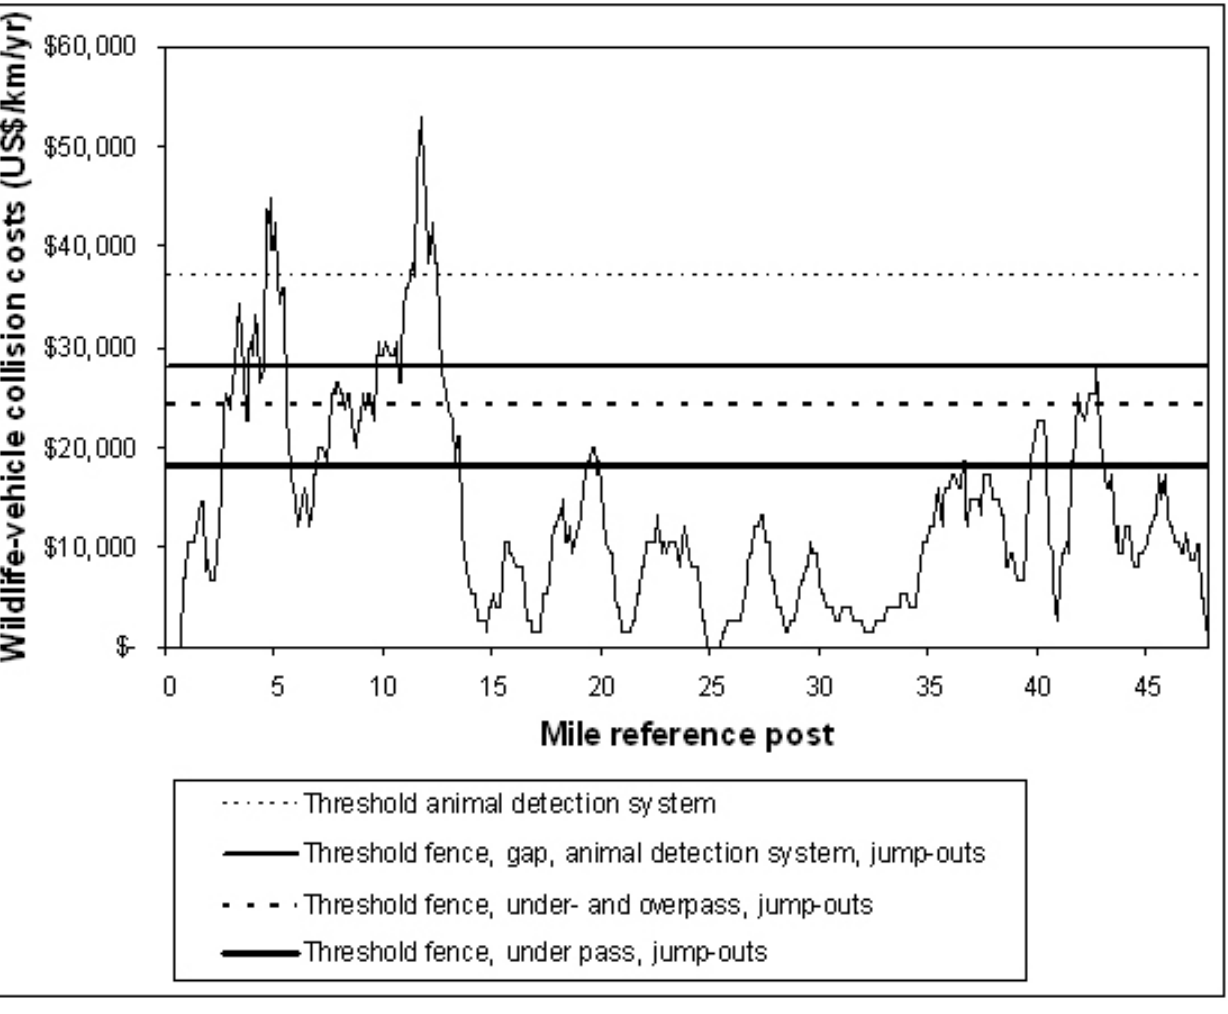
Fig. 8. The costs (in 2007 US$) associated with wildlife–vehicle collisions (deer and elk) along the two- lane MT Hwy 83 (mile reference posts 0.0–47.8) per year (average 1998–2003), and the threshold values (at 3% discount rate) that need to be met in order to have the benefits of individual mitigation measures exceed the costs over a 75-year time period. Note that the costs at each 0.1 mile concerned